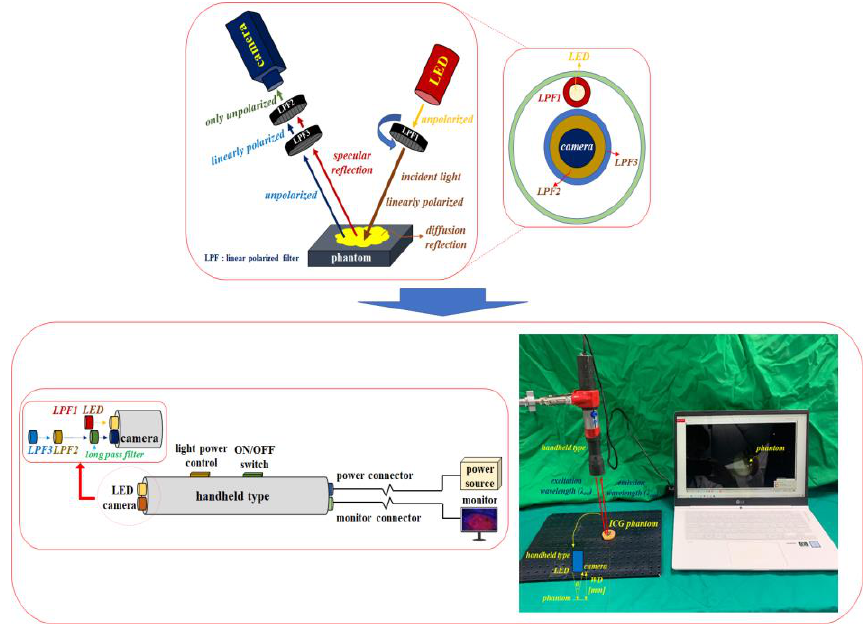
Figure 15. Construction of the experimental device.